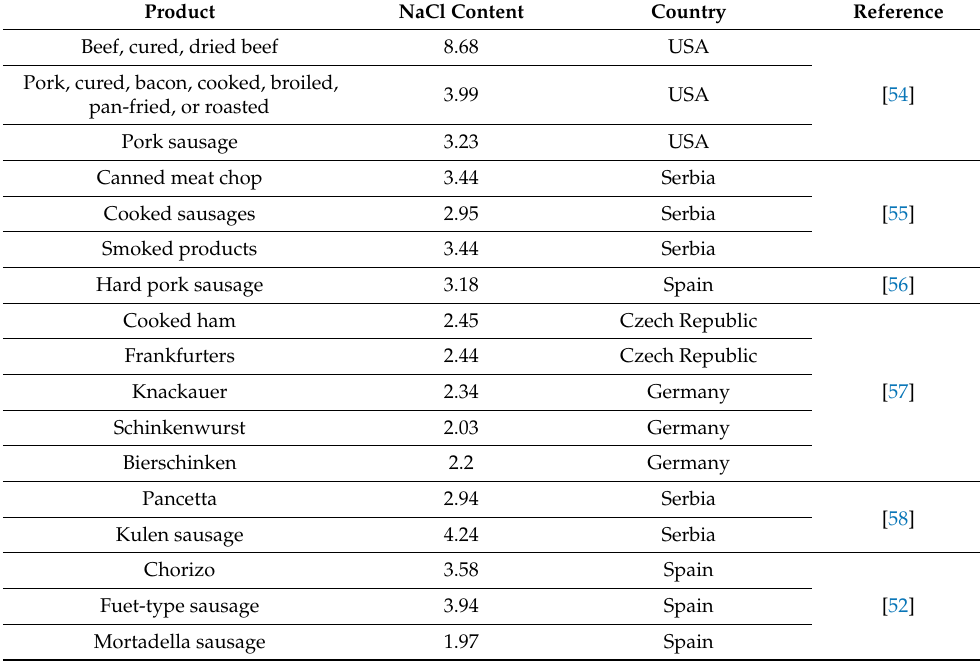
Table 1. Salt content in a selection of meat products from different